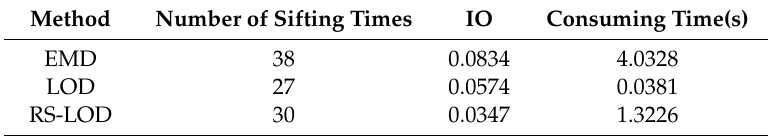
Table 1. Three assessing indicators for comparison among EMD, LOD, and RS-LOD methods.